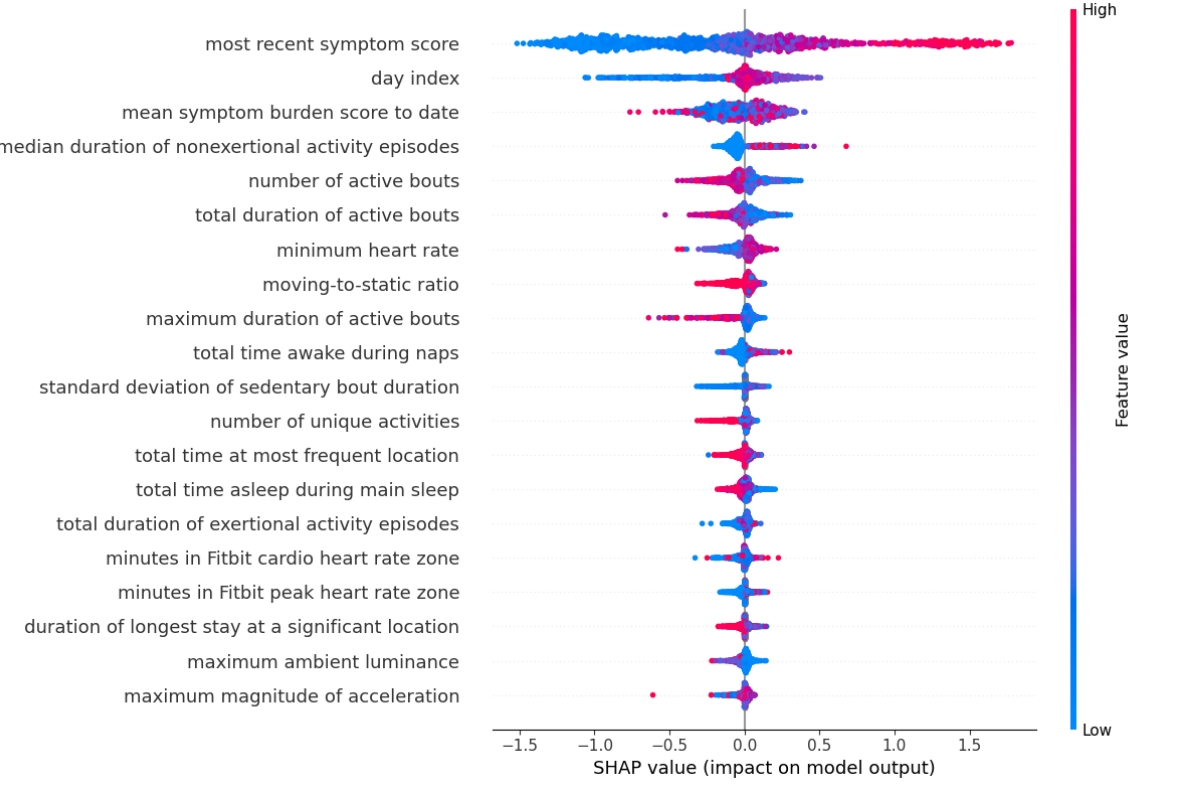
Figure 1. Density scatter plot showing SHapley Additive exPlanation (SHAP) values for each feature, reflecting how much impact each feature has on model output. Features with many instances in red with SHAP values greater than 0 are positively associated with symptom burden, while those with many blue instances are inversely associated with symptom burden.